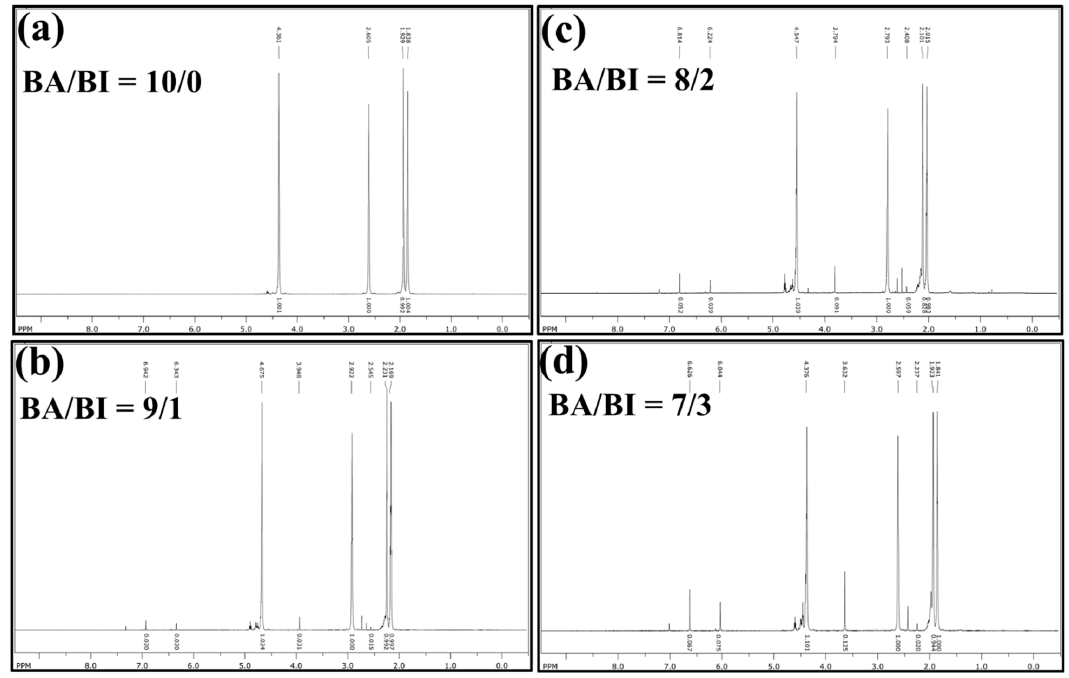
Figure 1. 1 H NMR spectra of PBABI copolyesters at ( a ) BA/BI = 10/0, ( b ) BA/BI = 9/1, ( c ) BA/BI = 8/2, and ( d ) BA/BI = 7/3.